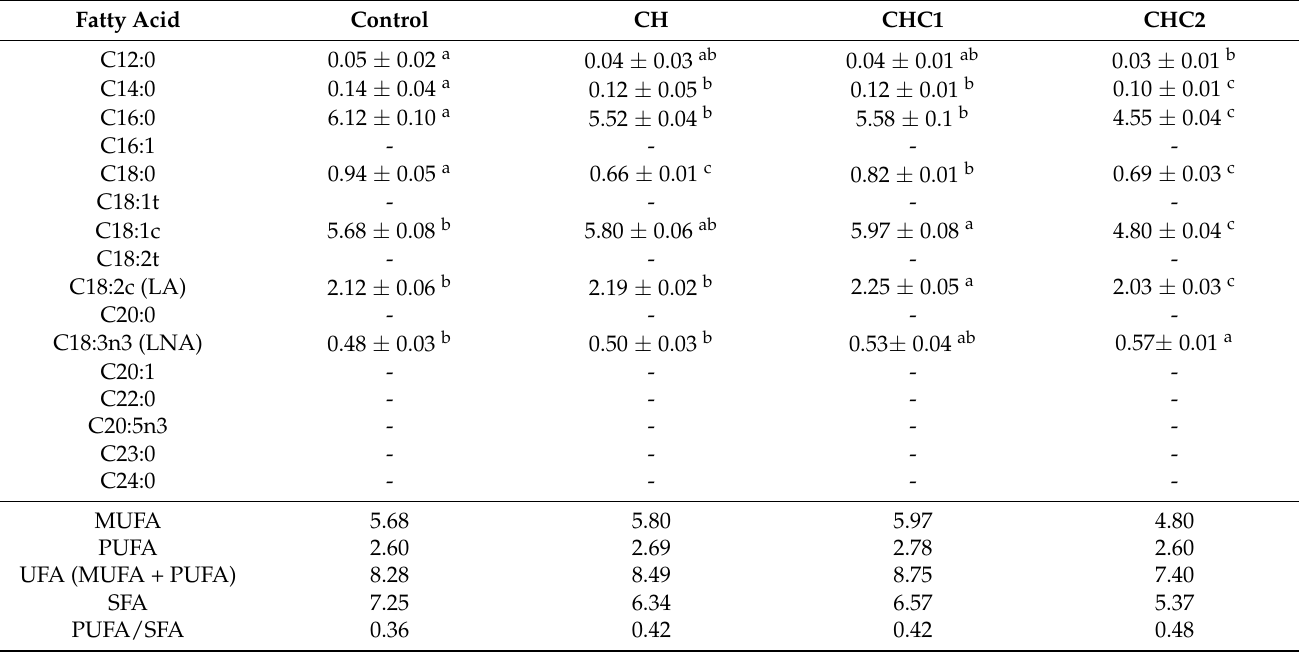
Table 2. Fatty acid profile (g/100 g sample) of gluten-free cookies.